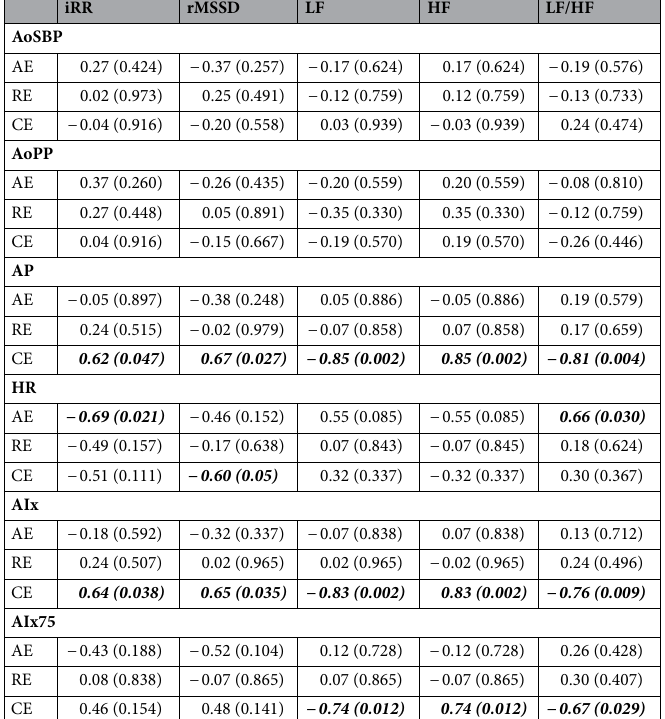
Table 3. Spearman correlations ( p -values) between changes in PWR and HRV outcomes (n = 15). Significant correlations in italic bold. iRR, RR (inter beat) intervals; rMSSD, square root of the sum of successive differences between adjacent normal RR intervals; LF, low-frequency band; HF, high-frequency band; LF/HF, sympathovagal balance; AoSBP, aortic systolic blood pressure; AoPP, aortic pulse pressure; AP, augmented pressure; HR, heart rate; AIx, augmentation index; AIx75, augmentation index normalized to 75